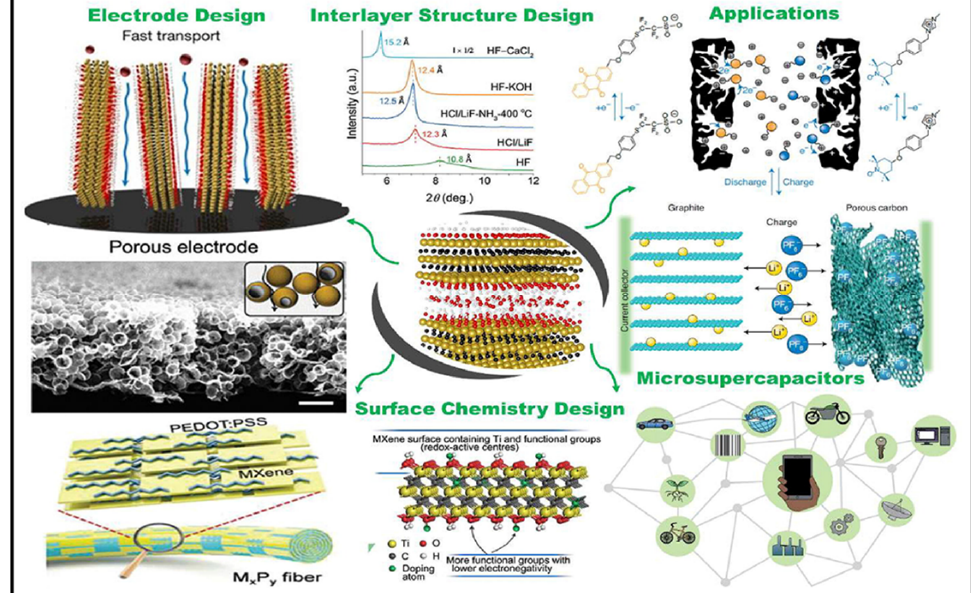
Figure 4. Modification design strategies for MXenes and applications, including interlayer structure design, surface chemistry design, electrode architecture design, and composites. Reprinted with permission from Ref. [55]. Copyright 2021 Journal of Electroanalytical Chemistry .